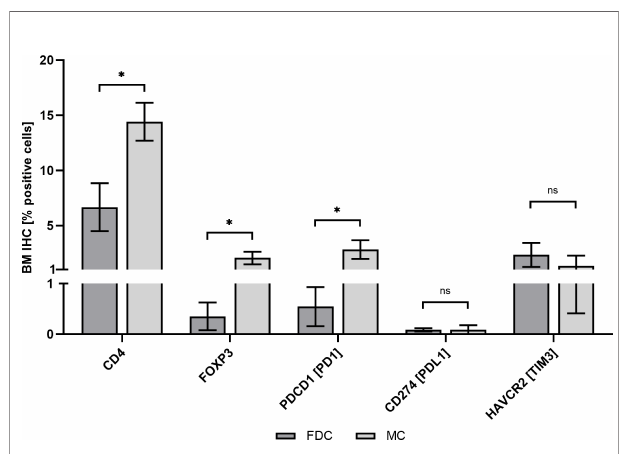
FIGURE 3 | Bone marrow immunohistochemistry assessment. Patients with FDC (n = 8) vs. patients with MC (n = 3). BM, bone marrow; FDC, full donor chimerism; IHC, immunohistochemistry; MC, mixed chimerism; ns, non- signi fi cant; * p <